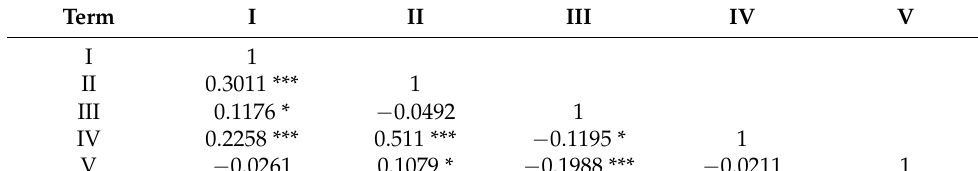
Table 6. Correlation coefficients between Mahalanobis distance, estimated at the five terms.